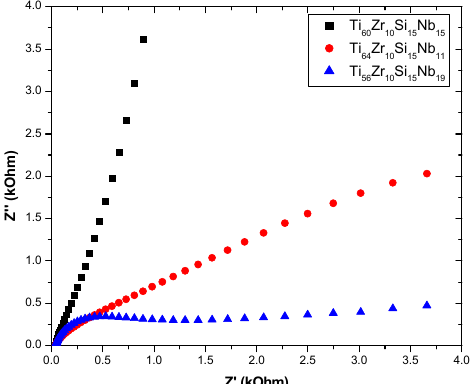
Figure 15. Nyquist impedance spectra in complex plane in NaCl 0.9% solution.